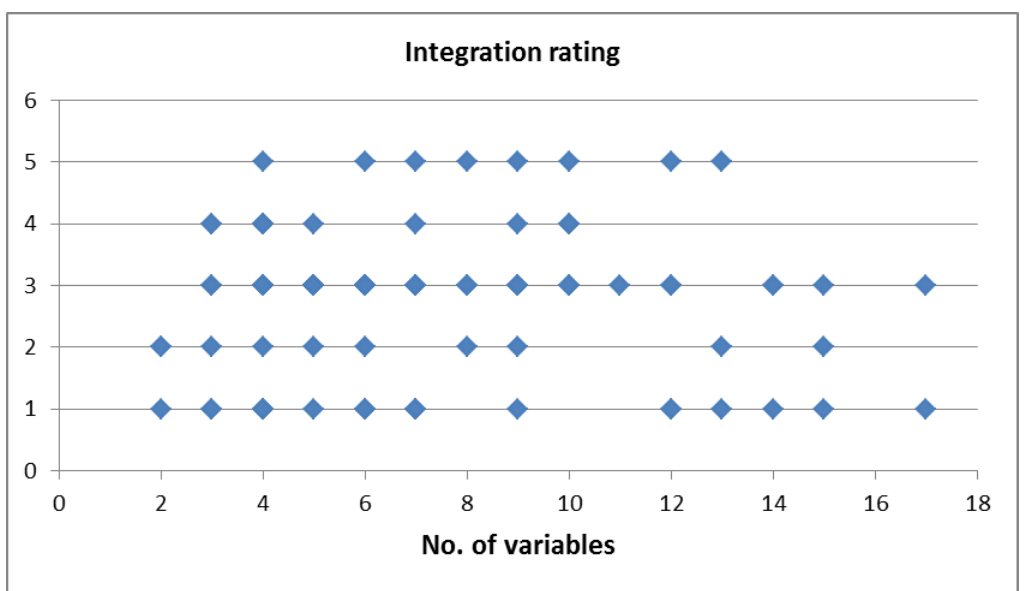
Fig. A4.2 Scatter plot indicating a lack of association between number of variables used in empirical studies and level of social-ecological integration. Some of the data points are overlaid on top of others because more than one study could have used the same amount of variables and rated equally for